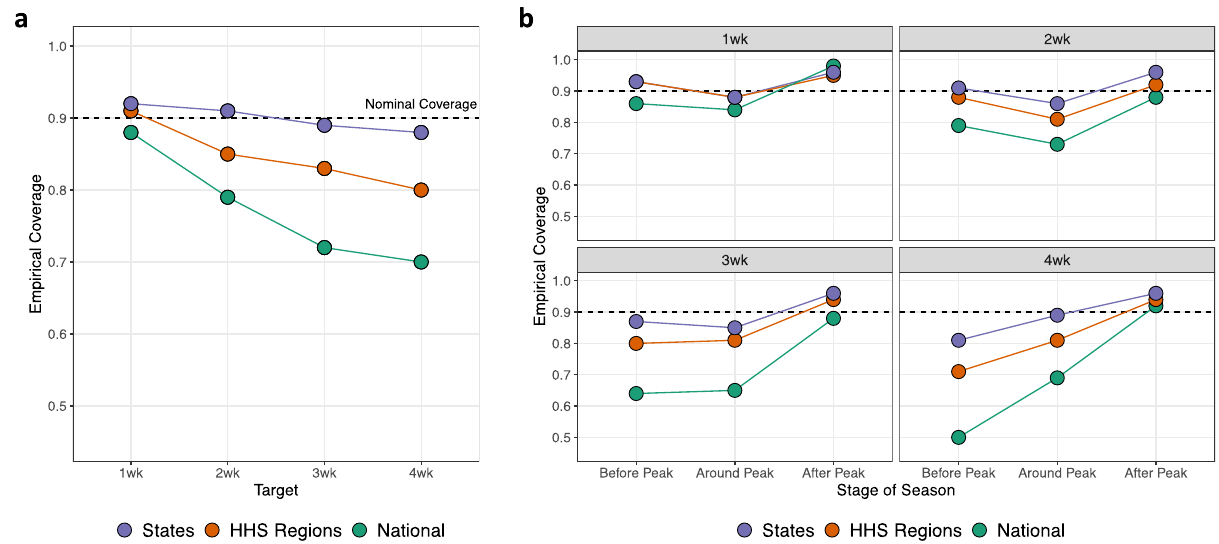
Fig. 7 Dante ’ s empirical coverage. Dante ’ s 90% empirical coverages for short-term targets, broken down by geographic scales. b Empirical coverages by target averaged over all seasons, geographic units within scale, and stages of fl u season. a Empirical coverages broken out by stages of fl u season. The “ Around Peak ” stage is de fi ned as the peak week, plus/minus 2 weeks inclusively. Generally, empirical coverages degrade as the forecast window increases, as geographic scales coarsen, and as we get earlier in the fl u season. The disagreement between empirical and nominal coverage for Dante represents an opportunity for iteration and improvement.